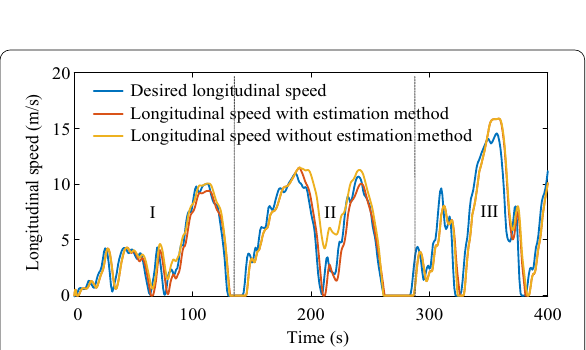
Figure 15 Results of the speed tracking